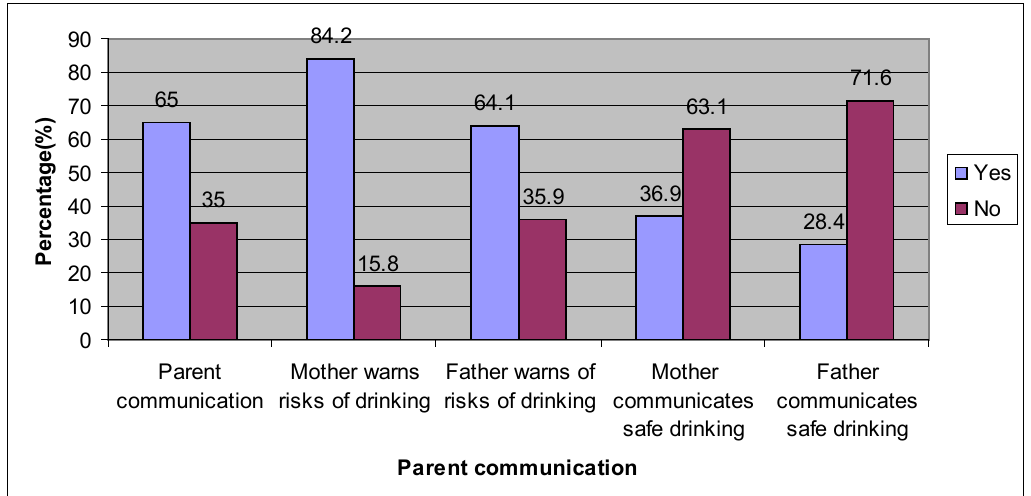
Figure 1. Parental communication with adolescents regarding risky and safe alcohol